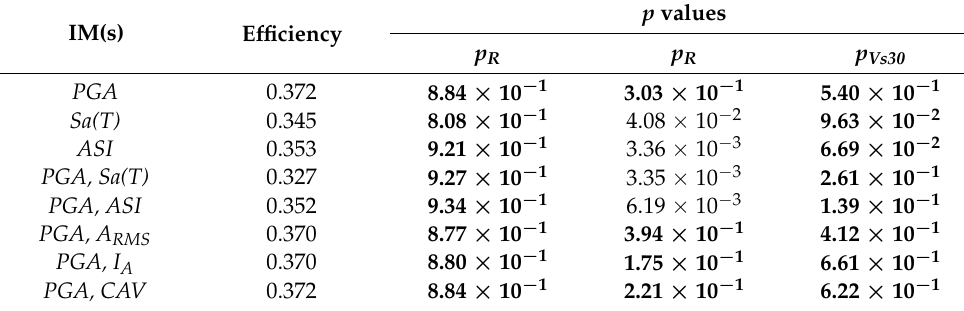
Table 9. Efficiency and p values for frames < 0.5